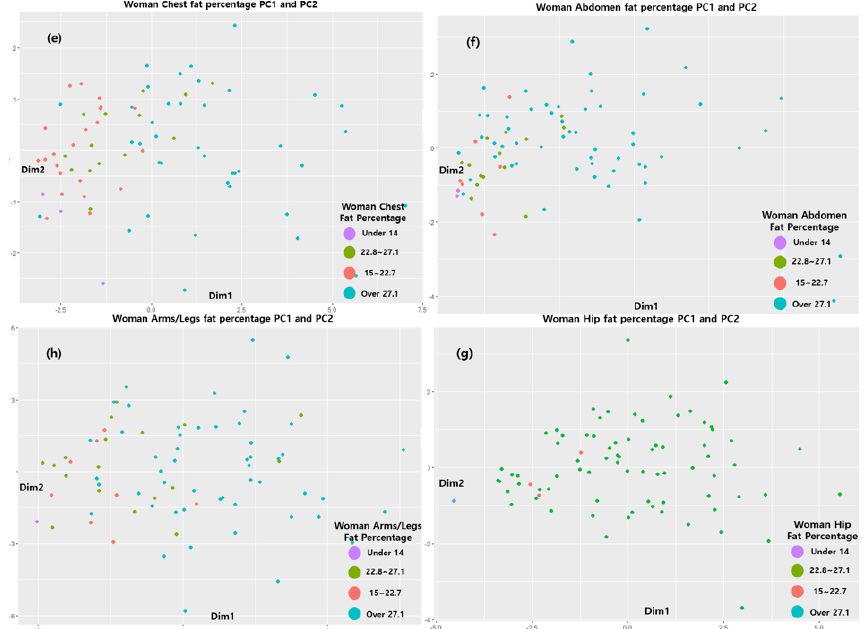
Figure 6. PC 1 and PC 2 results for ( e ) female chests, ( f ) female abdomens, ( g ) female hips, and ( h ) female arms-legs.